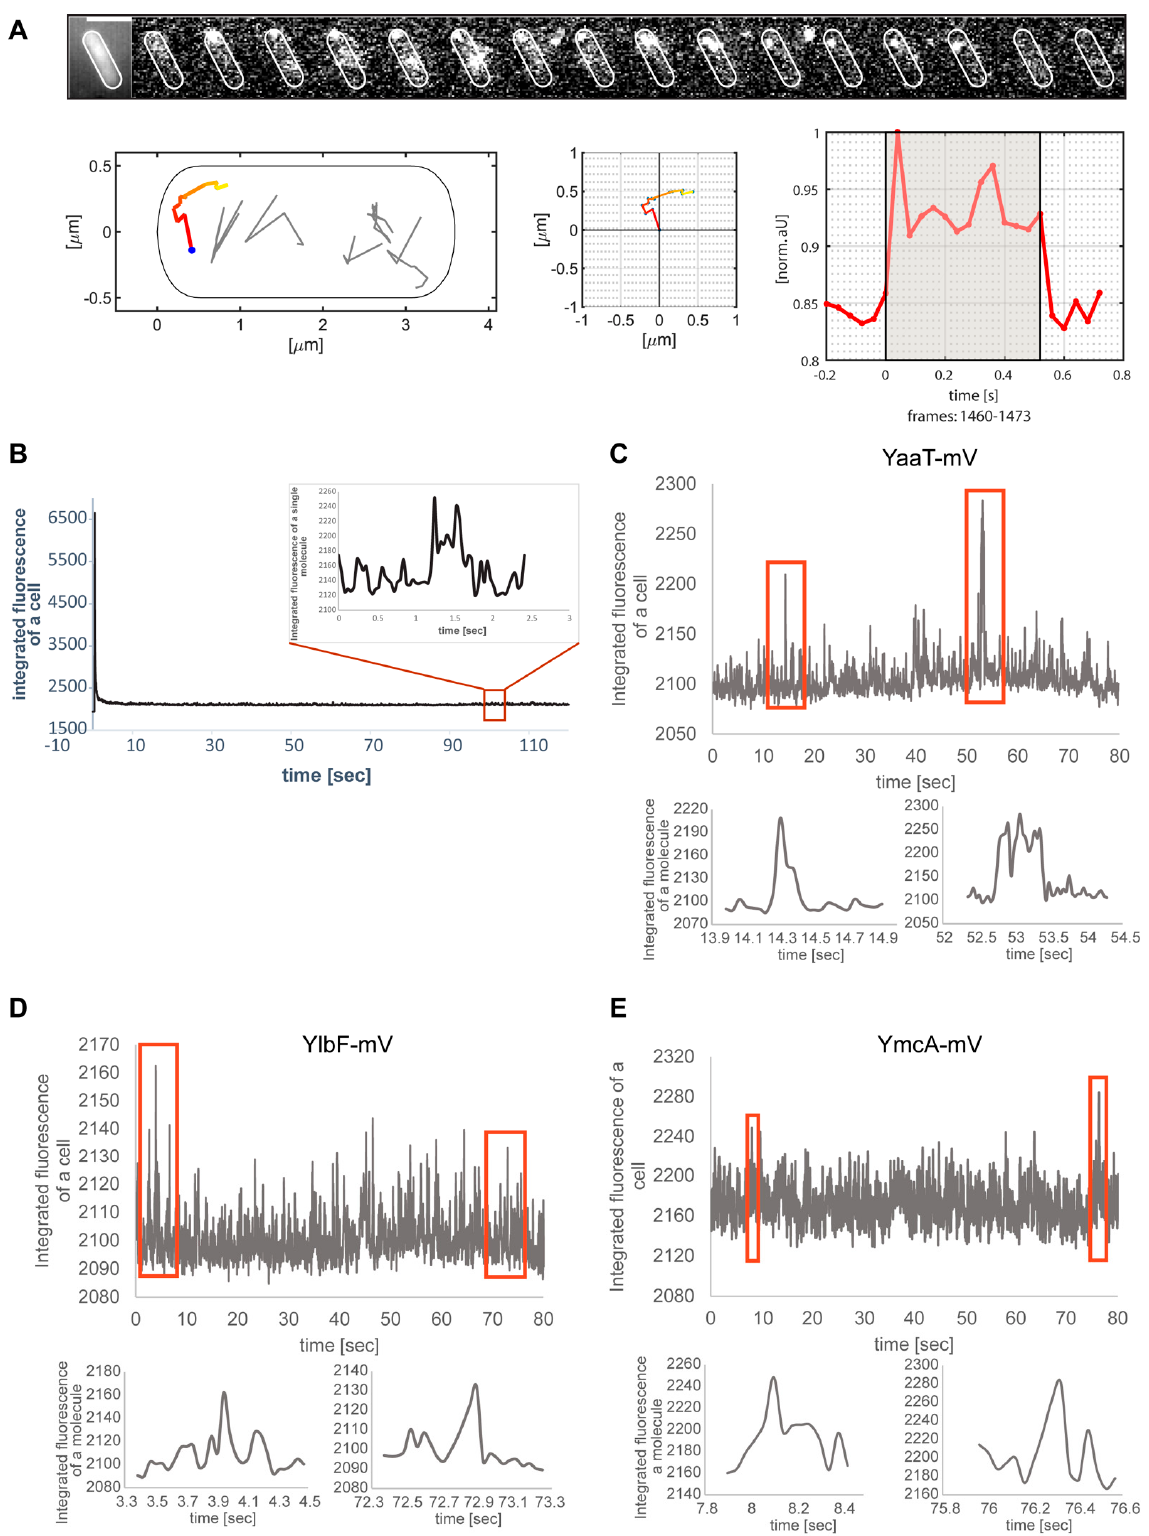
Figure 3. Single-molecule/particle tracking of Y-complex proteins. ( A ) Exemplary track of YaaT-mV. Montage shows images captured by 40 ms stream acquisition. Middle panels show motion of the focus within 2D, and fluorescence in arbitrary units. ( B ) Bleaching curve of the movie from panel A, inset shows track from panel A. ( C ) Examples of fluorescence for two or three molecules adding to a YaaT assembly within single frames, ( D , E ) track events for YlbF-mV or for